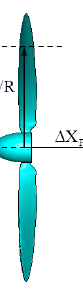
8 of 16 Figure 7. Spanwise pressure distribution of the wing: ( a ) x/c = 0.25; ( b ) x/c = 0.5. ( Ma = 0.1017, o =2  , = 4400 min r 